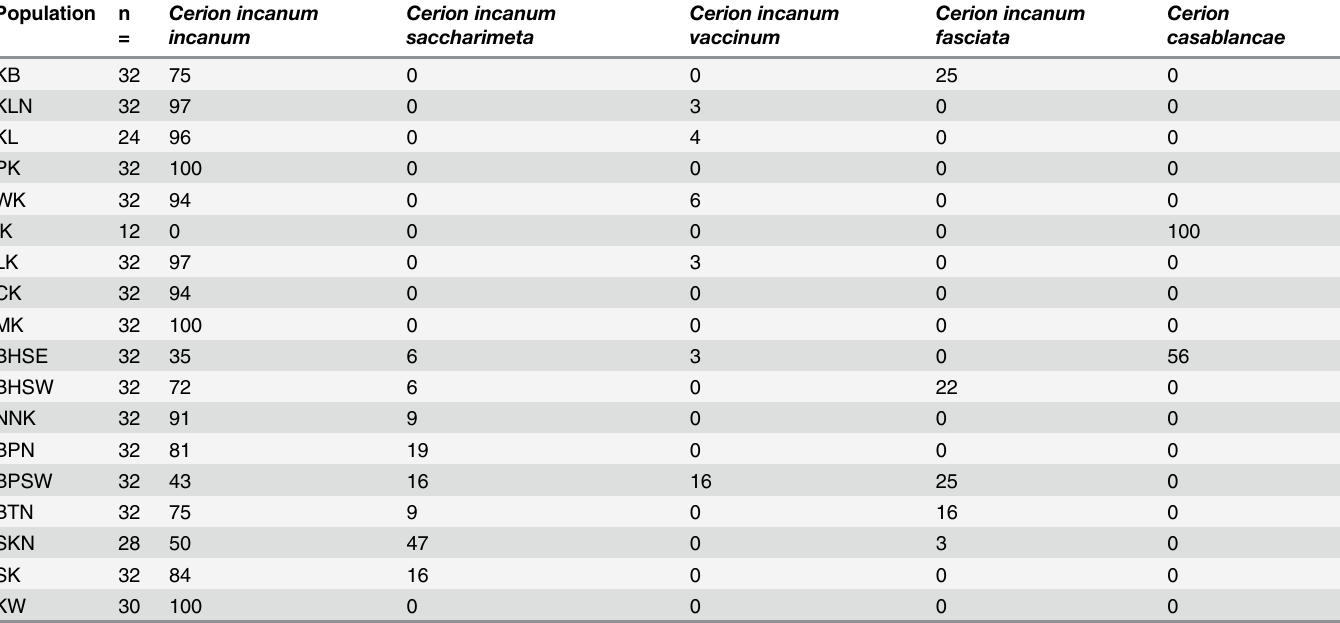
Table 2. Distribution of shell phenotypes within and among the sampled Cerion populations as % of each population. Images of specimens are appended to their catalog records http://collections.nmnh.si.edu/search/iz/ (search by catalogue number in Table 1). Population n